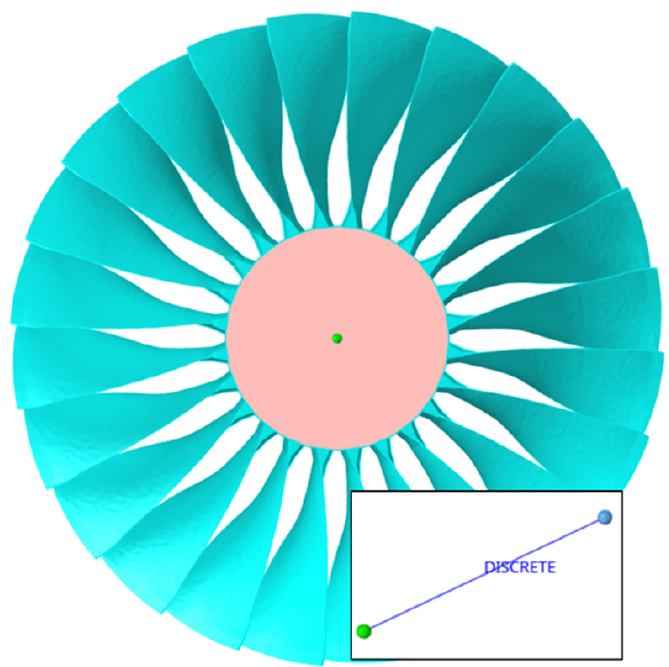
Figure 4. The modeling of bearing in bird strike simulation.